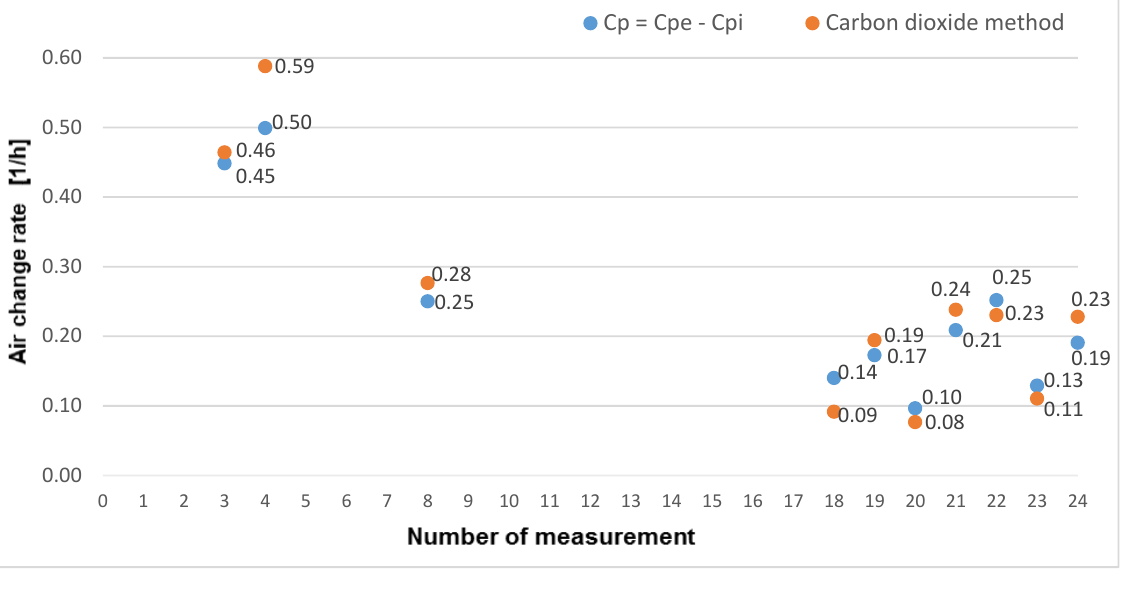
Figure 14. The difference between values of air change rate taking into account the influence of openings C p = C pe − C pi and the values based on experimental measurements of carbon dioxide for higher wind speed v = 4.4 m/s–10.3 m/s.